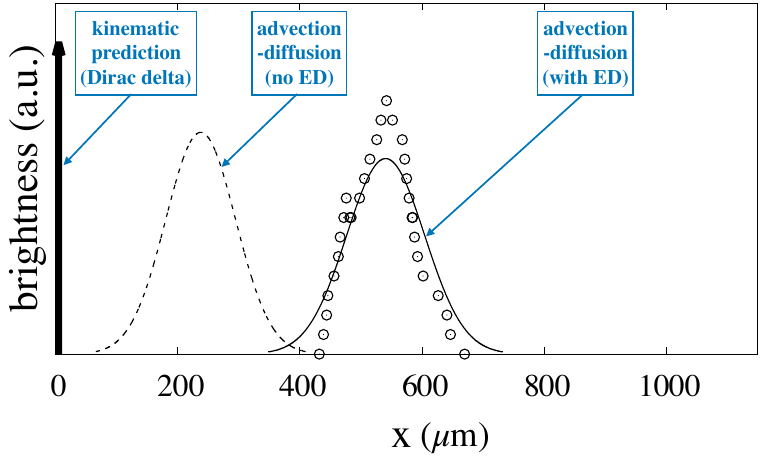
Figure 9. Comparison between the experimental values of the fluorescence intensity at a distance L = 11mm downstream the particle feeding source for particles of size r p = 0.3 µ m and the distribution resulting from the fitting of the advection–diffusion model with electrostatic effect to the experimental data. Empty symbols: experimental values taken from [6]; Continuous line: advection–diffusion model with ED computed by assuming a value of d F − EDL that makes the mean value of the experimental and predicted distribution equal. Broken line: advection–diffusion model with no electrostatic effect. The thick arrow represents the Dirac delta distribution predicted by the kinematic theory for this system geometry and the chosen particle size. All of the distributions have been normalized so that they possess equal